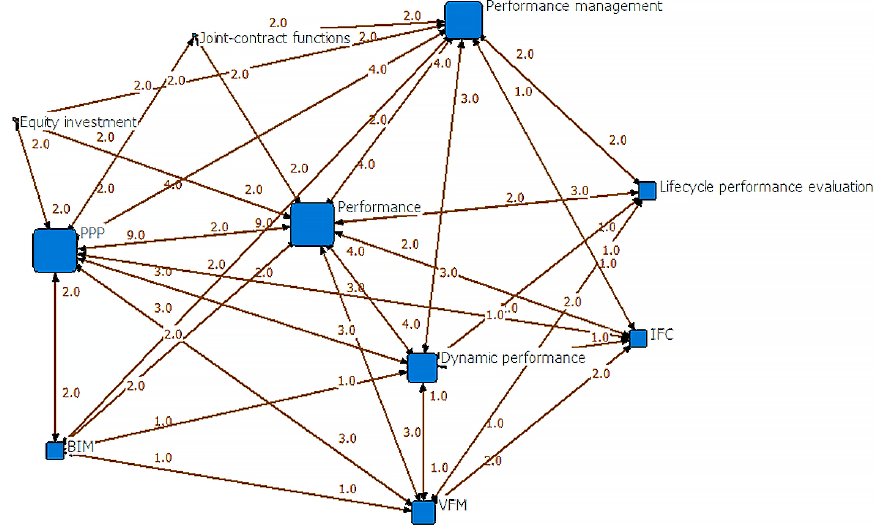
Figure 8. Performance management topics in